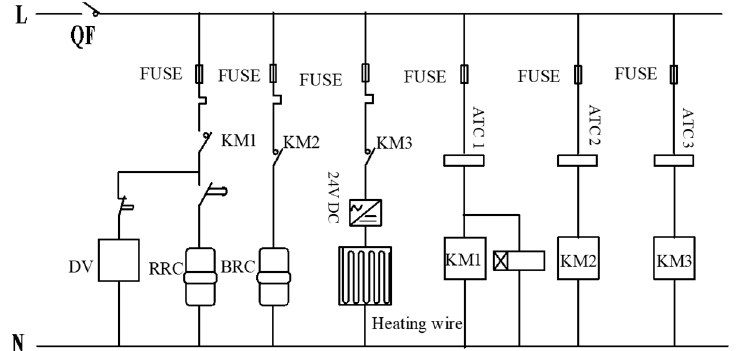
Figure 4. Circuit design of the frost chamber controller.